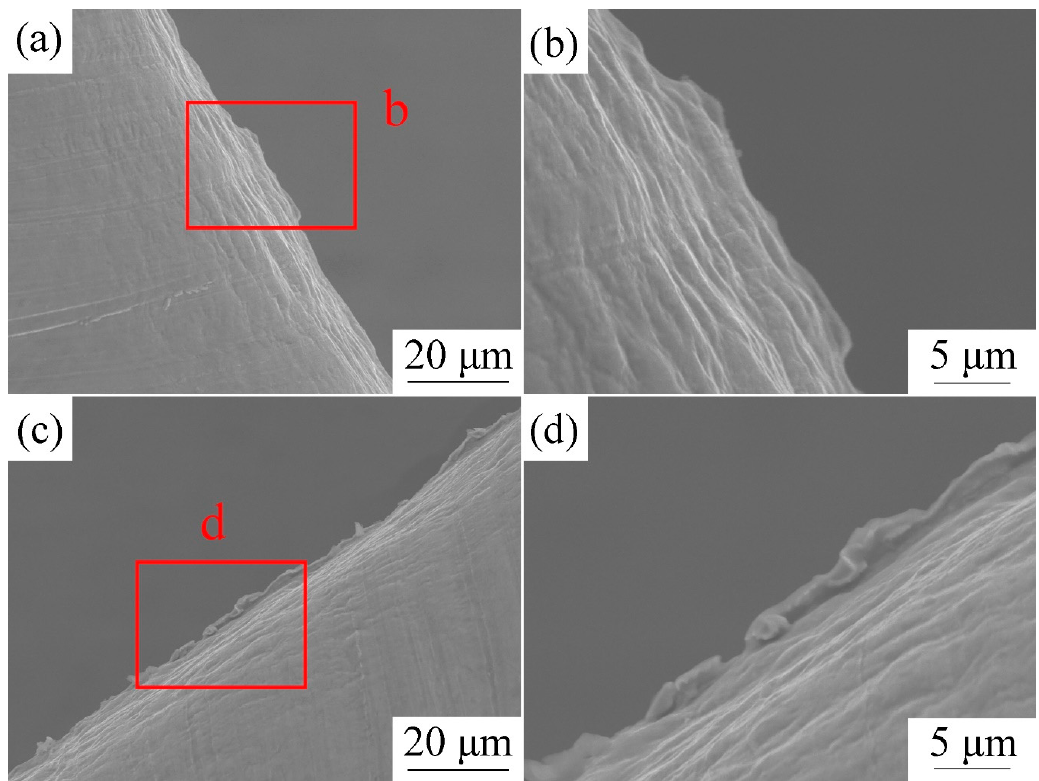
Figure 11. SEM observations of the punched holes under a laser energy density of 38.2 J/cm 2 . ( a ) The punched hole without LPS; ( b ) corresponds to the region “b” in ( a ); ( c ) the punched hole with LPS; ( d ) corresponds to the region “d” in ( c ).